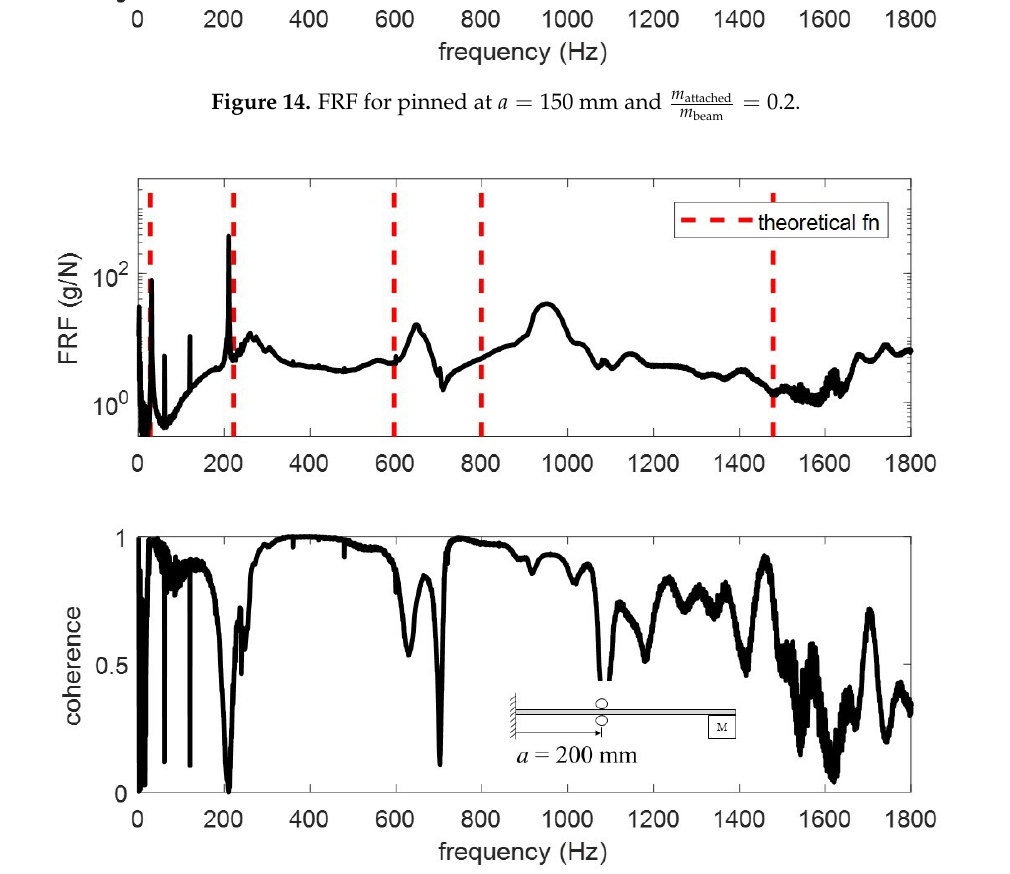
Figure 15. FRF for pinned at a = 200 mm and m attached